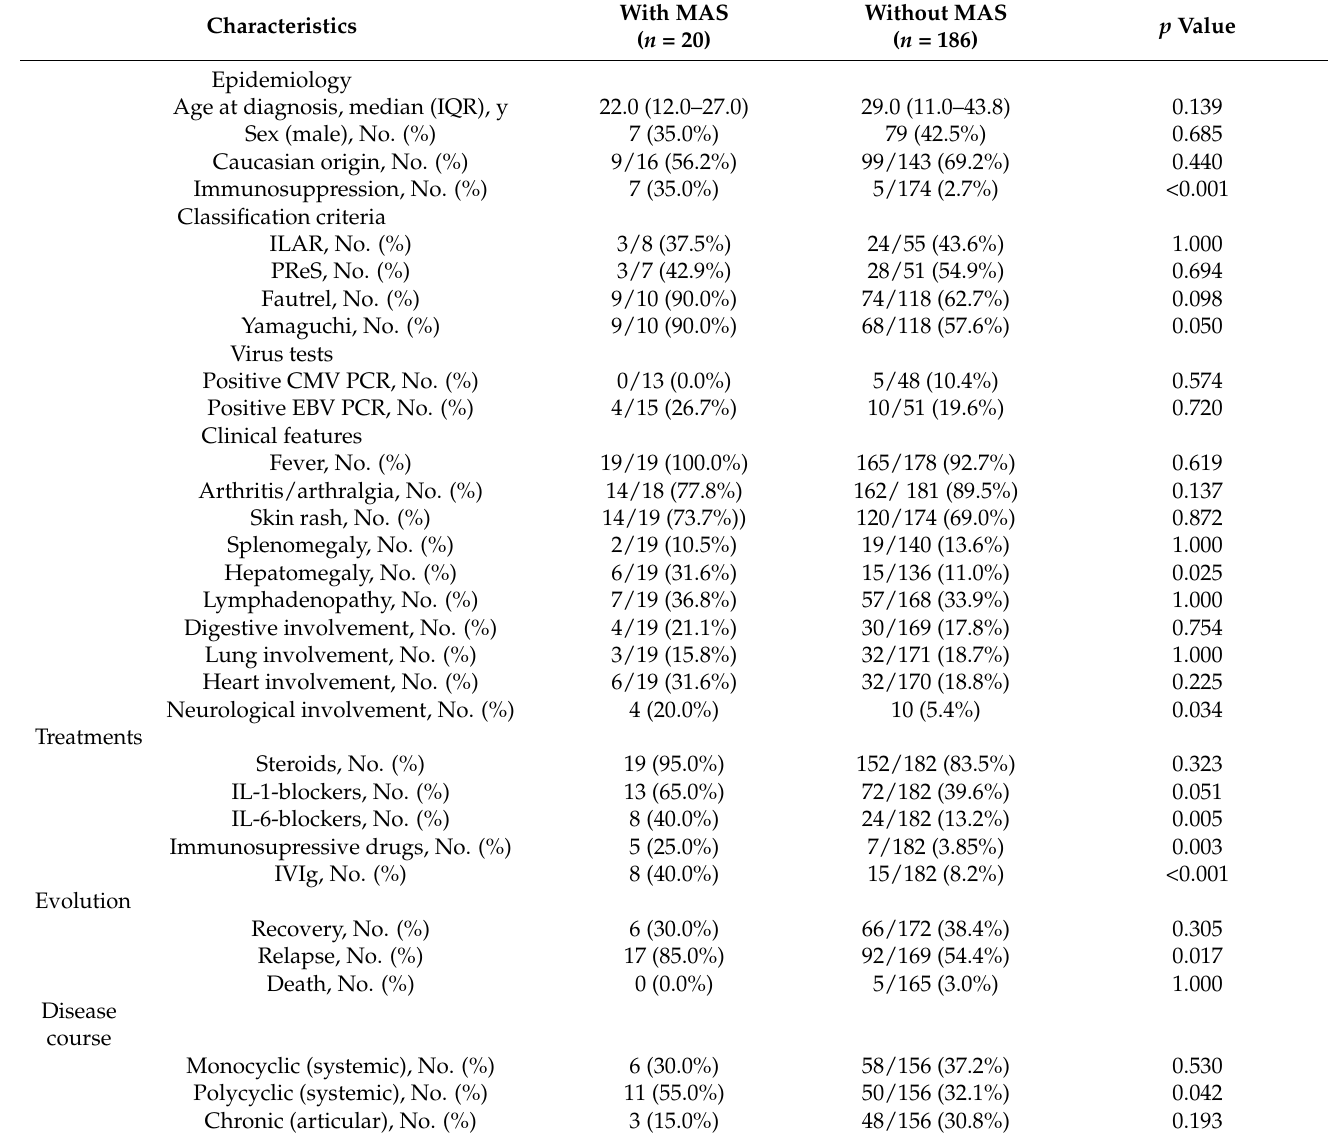
Table 2. Comparison of clinical characteristics of SD patients with and without